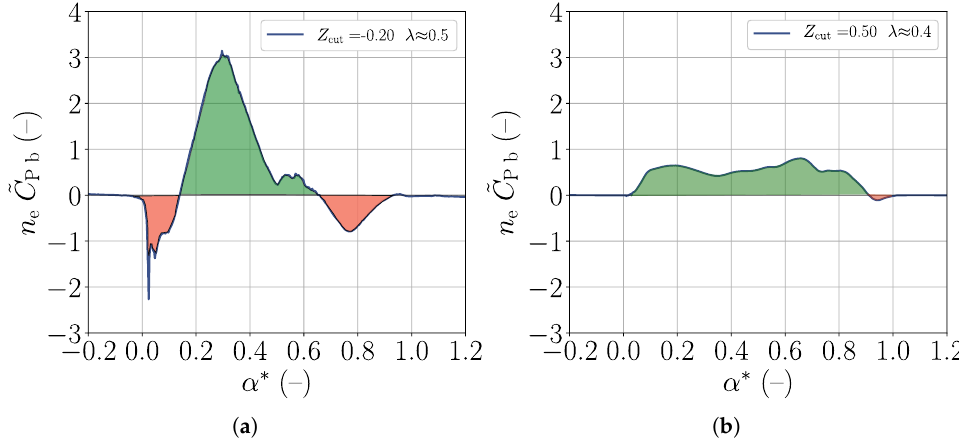
Figure 13. Torque distribution represented by n e ˜ C P,b vs. α ∗ curve for previous (top) and current (bottom) optimisation study. ( a ) Wheel selected from previous optimisation. ( b ) Optimal wheel from current